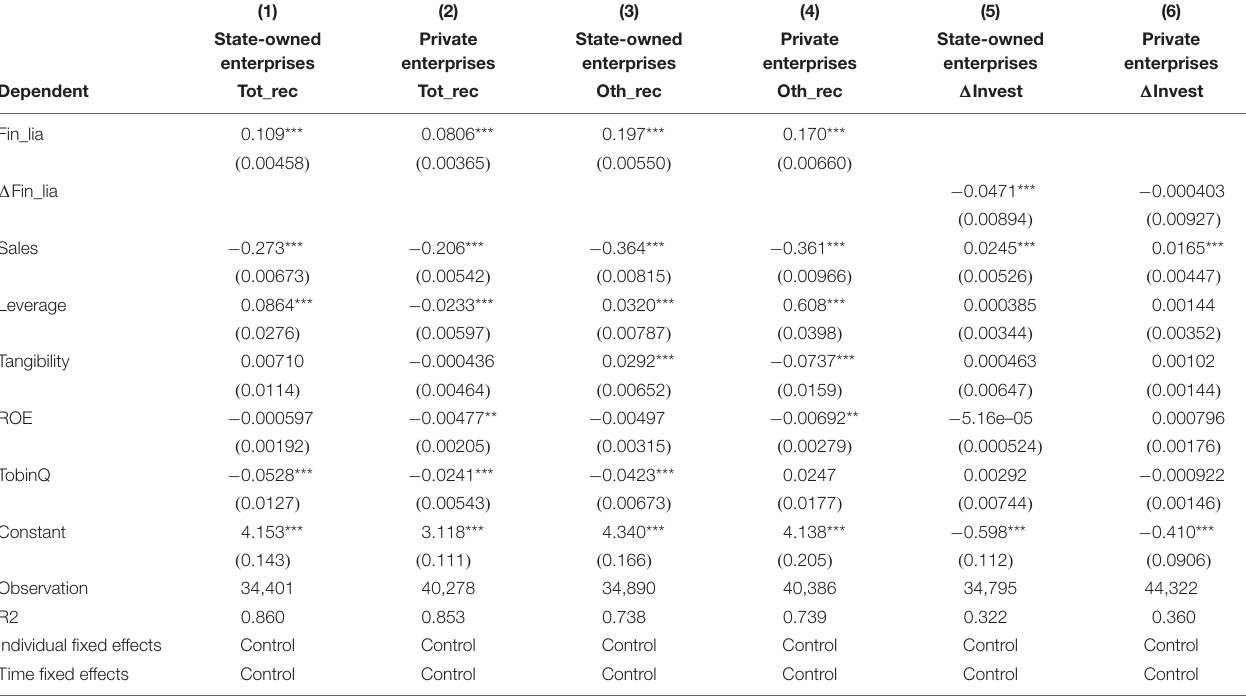
TABLE 5 | “Borrow to Lend” identification models 2 and 3: Enterprise heterogeneity.